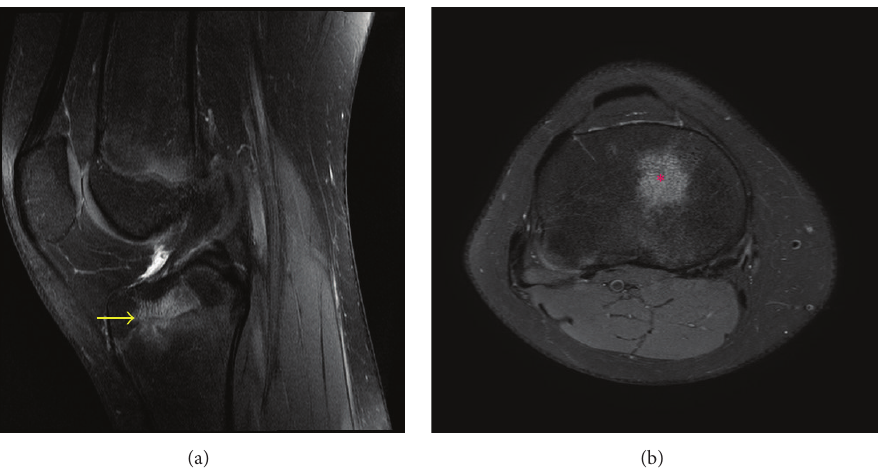
Figure 8: A 14-year-2-month-old female with FOPE zone of the proximal tibia. Findings: (a) sagittal proton density image shows 14mm in diameter area of periphyseal edema involving both sides of the proximal tibia physis (arrow). Edema is greater along the epiphyseal side of the physis. (b) Axial proton density image at the level of the proximal tibia physis shows the area of periphyseal edema within the anteromedial aspect of the central proximal tibia (asterisk). Technique: (a) sagittal PD fat-saturated MRI (TR = 2,922.8, TE = 30), ST = 3mm, spacing = 3.3 mm, FOV = 14 cm, and matrix = 364 × 261; (b) axial PD fat-saturated MRI (TR = 2,803.1, TE = 30), ST = 3 mm, spacing = 3.3 mm, FOV = 15cm, matrix = 376 × 297.